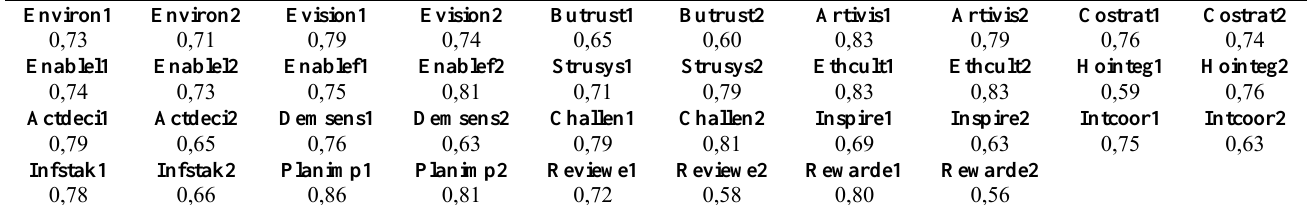
Table 11: Squared multiple correlations for item